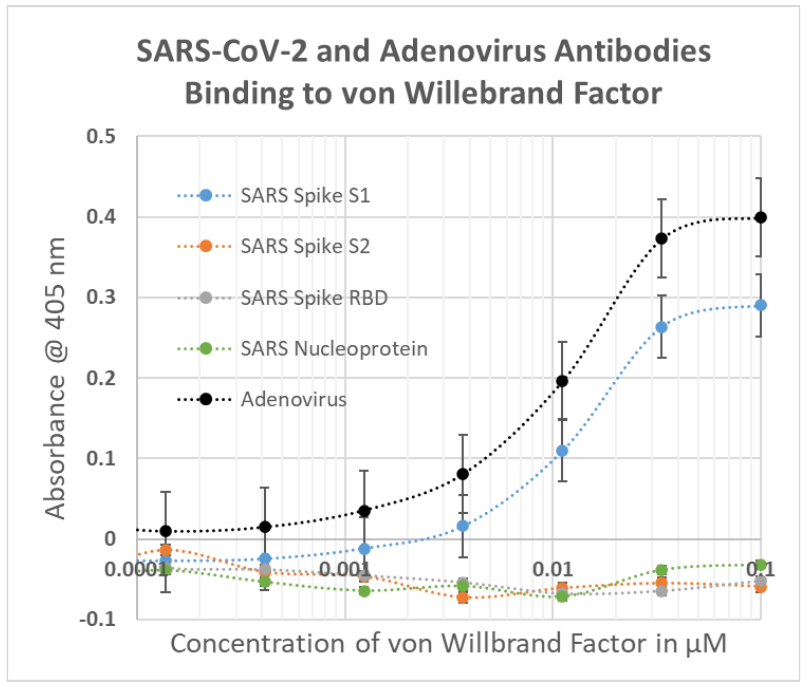
Figure 4. ELISA results showing SARS-CoV-2 (SARS) and adenovirus polyclonal antibodies (rabbit) binding to von Willebrand Factor (vWF). Experiments were run in duplicate.